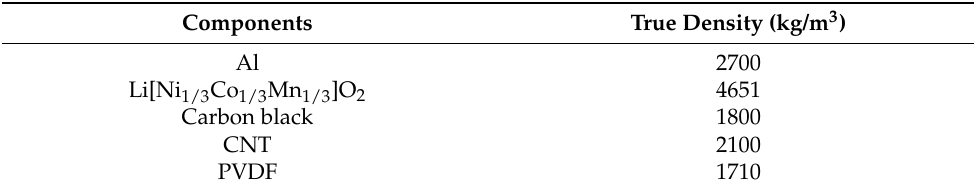
Table 1. True density of substance in the positive electrode.